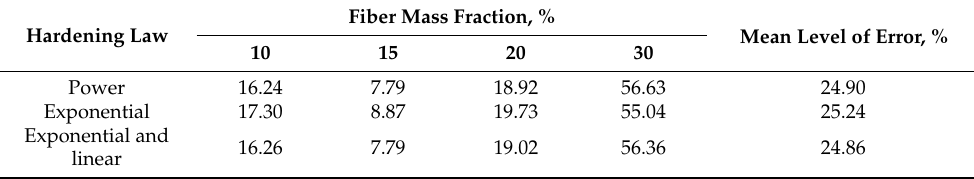
Table 7. Mean relative error (%) of ultimate strain prediction for different fiber mass fraction compos- ites with models based on fiber and matrix characteristics obtained experimentally, mean fiber aspect ratio calibrated models, and the mean parameter